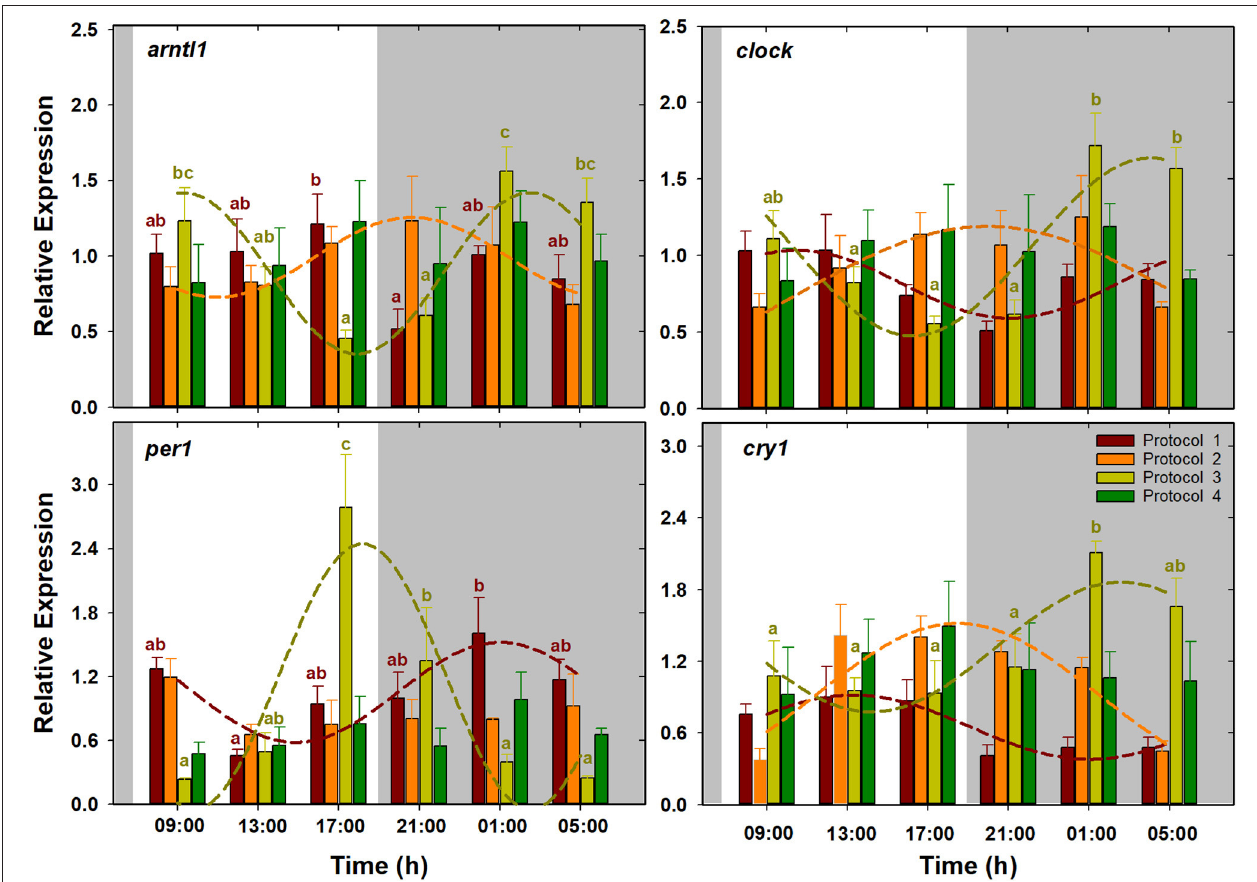
FIGURE 2 | Daily patterns of arntl1 , clock, per1 , and cry1 expression in S. senegalensis with different feeding protocols. Within each protocol, different letters denote significant differences among sampling times (one-way ANOVA, Tukey’s test). Short-dashed lines exhibit expression patterns with significant circadian rhythm (cosinor analysis). For each feeding protocol, N = 6 individuals per sampling point ( p < 0.05). Gray areas indicate the dark period.